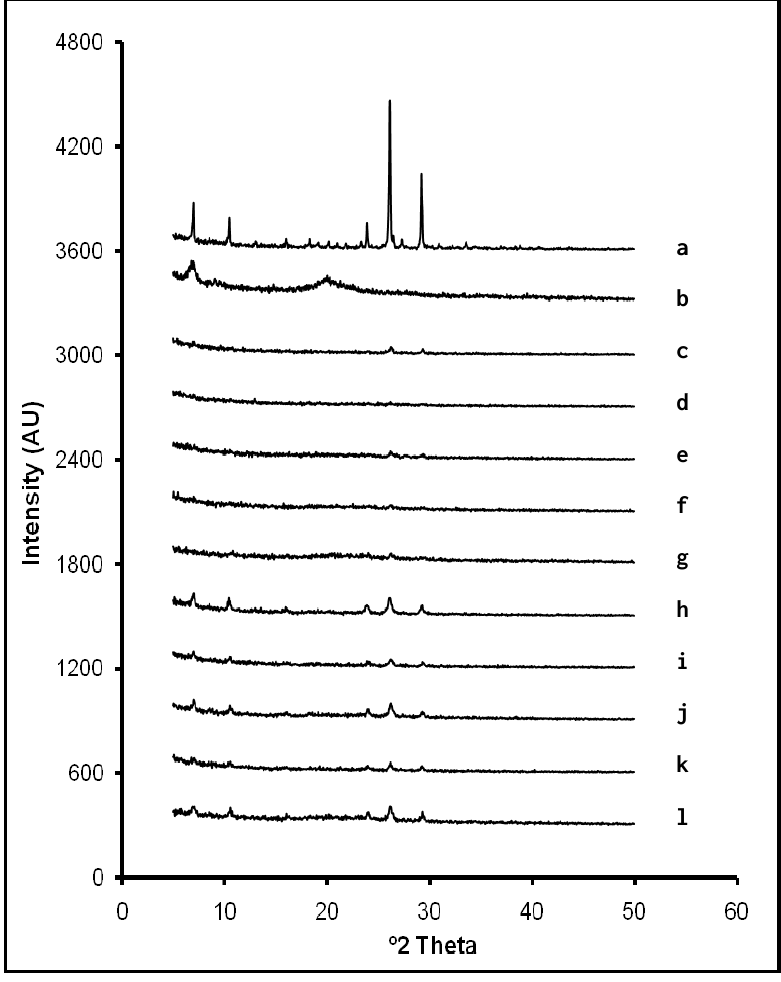
Figure 1. X-Ray powder diffraction patterns of ACV ( a ); CS ( b ); and systems L1